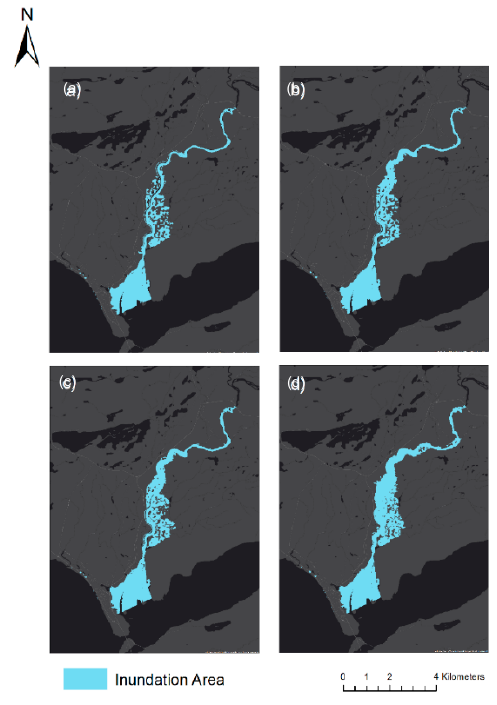
Figure 4. Comparison between 2D simulated flood inundation extents using different mesh sizes (around break line): ( a ) 100 m (70 m), ( b ) 50 m (30 m), ( c ) 30 m (30 m), ( d ) 20 m (15 m). Table 2. Comparison of 24 h rainfall (mm) amounts generated based on WRF- and GCM-IDF curves based on six GCMs.